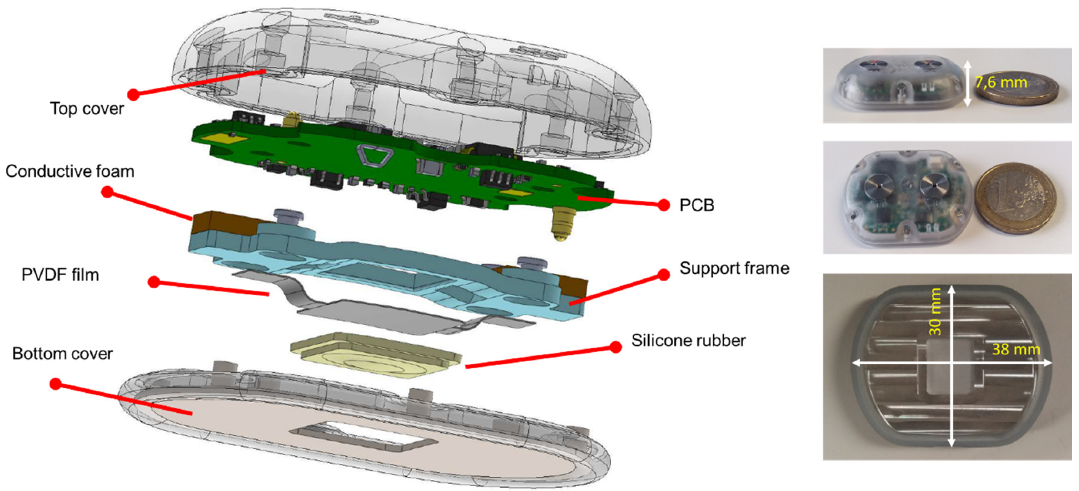
Figure 4. ( left ) Exploded view of the sound acquisition module and ( right ) images of the assembled sensor with its dimension; from top to bottom: side view of the sensor with 1 euro coin, top view of the sensor with 1 euro coin, and bottom view of the sensor.